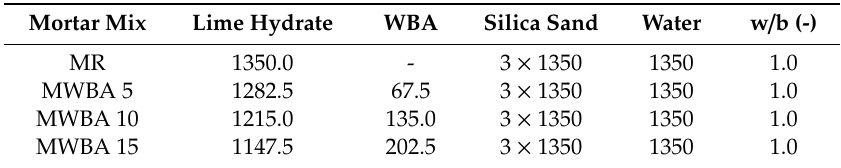
Table 1. Composition of studied mortars, mass (g). WBA: wood-based biomass ash; MR: reference lime